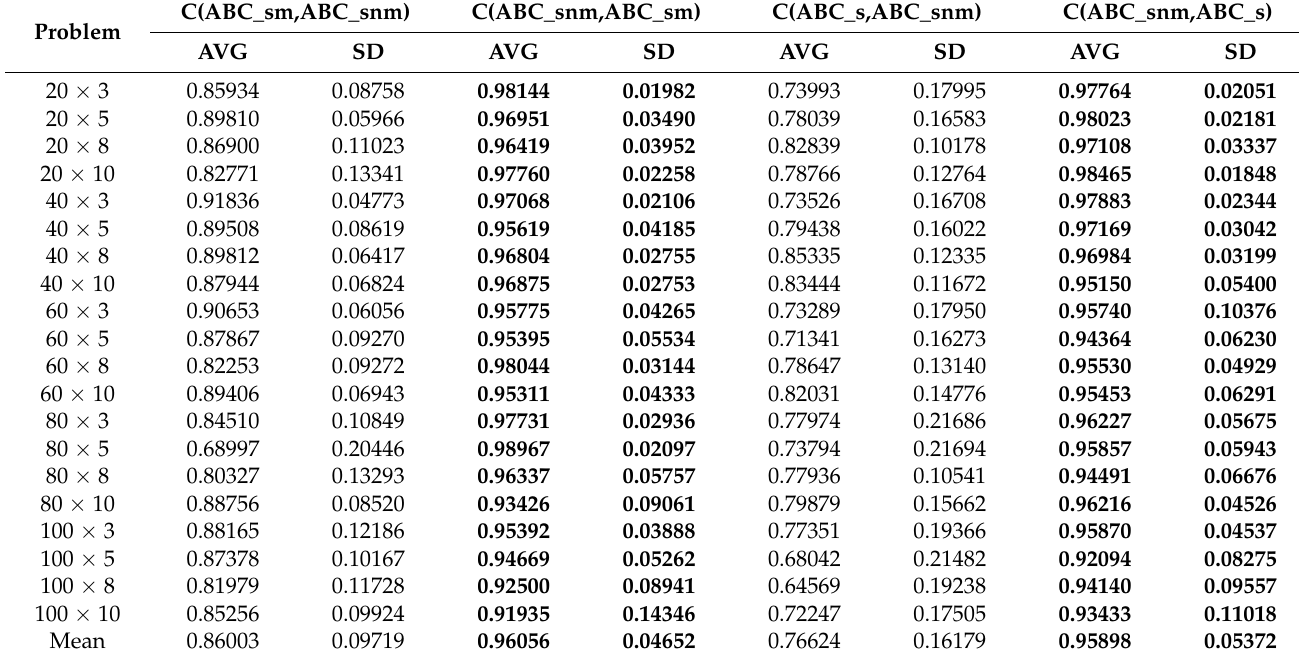
Table A5. C -metric for selection strategy.